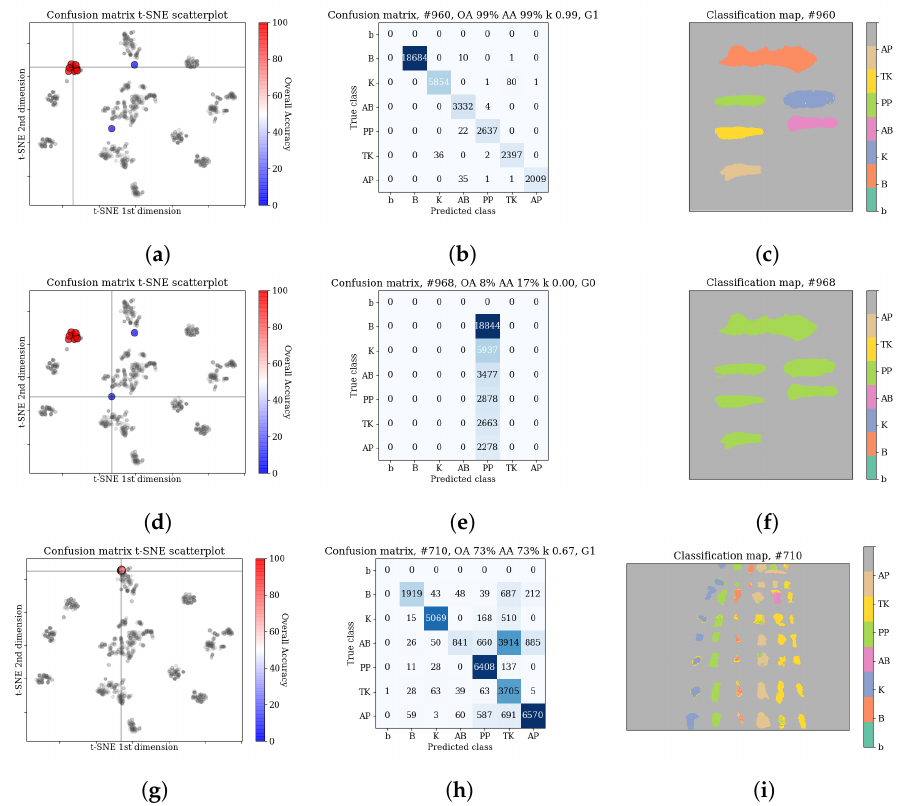
Figure 10. Example steps of the qualitative inspection of the experimental results (see Section 3.3.2). The rows present three separate inspected cases. The columns contain the inspected data: a scatterplot of t-SNE projected confusion matrices, the case confusion matrix and a classification map. On the scatterplot the grey points represent classification results for all images, while the marked points are connected with the presented case. Scores of the relevant scenario (network/images) were emphasized. The first two rows present the scenario of the 3D CNN [11] network on F(2k) image; the result is relatively high and comparable with others results with mean OA of 99.2% ± 1.7%, it contains two detectable outliers, which results from failure of training. Inclusion of them in the score would drop the mean OA to 80.9% ± 36.7%, which would hide the real capabilities of this network. Such results were thus excluded. Bottom row: the RNN [14] network on F(1a) → E(1) ; consistent performance verified by the low dispersion of the confusion matrices and their similar shape for subsequent